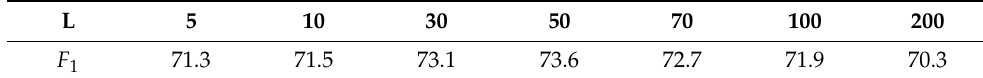
Table 7. Results of different